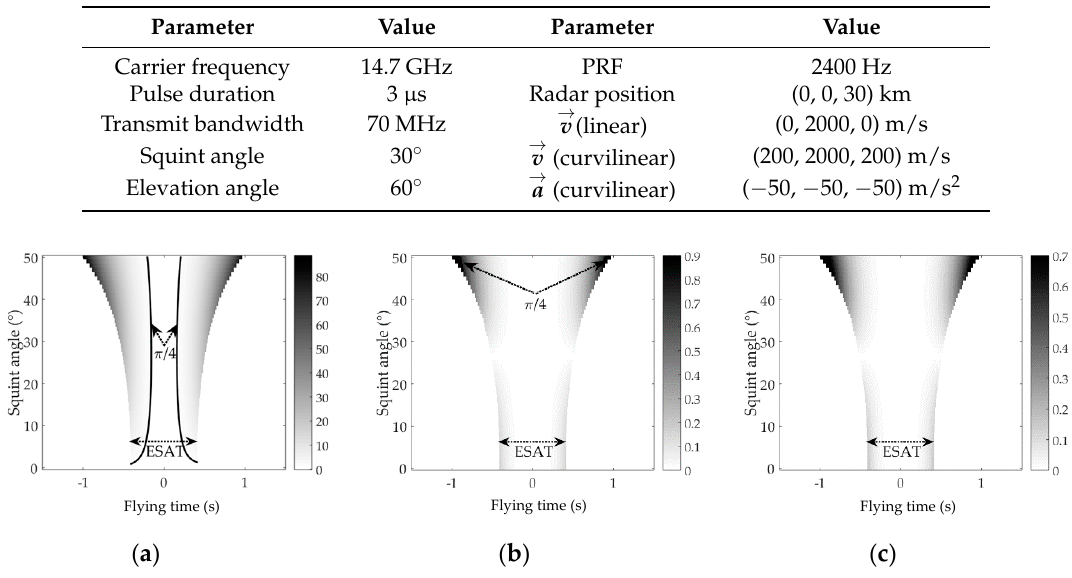
Figure 2. Phase errors for different range models: ( a ) second ‐ order model; ( b ) third ‐ order model; and ( c ) fourth ‐ order model.